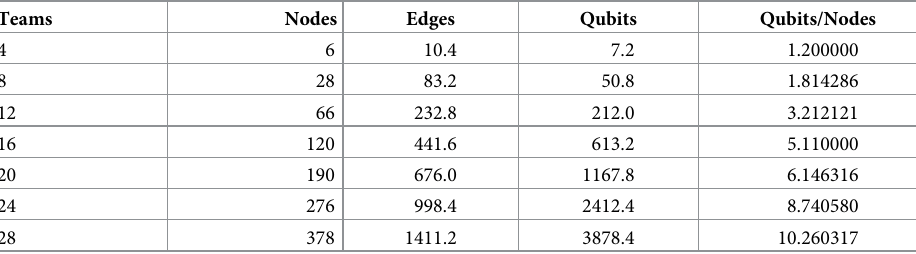
Table 4. Number of nodes and edges of the source graph and qubits used in